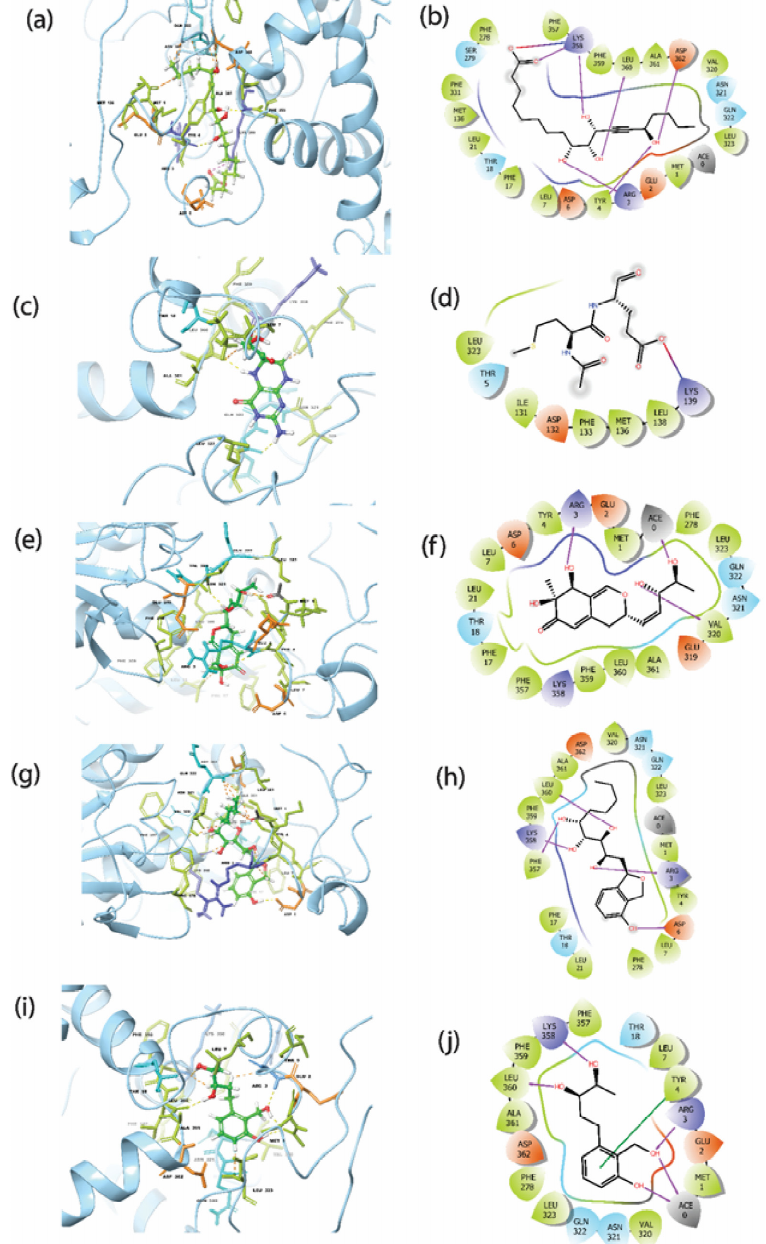
Figure 3. 3D and 2D interaction profile of the MPXV cysteine protease with the top screened natural compounds ( a,b ) Gallicynoic Acid F, ( c,d ) H2 Erythro ‐ Neopterin, ( e,f ) Nigcollin C, ( g,h ) NPA024545, and ( i,j ) Vaccinol M.